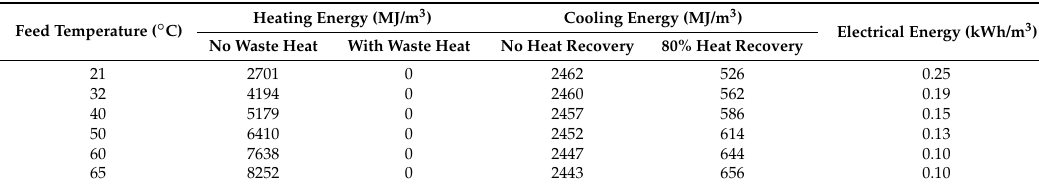
Table 3. Thermal and electrical energy requirement per m 3 of permeate with/without heat recovery and alternative heat